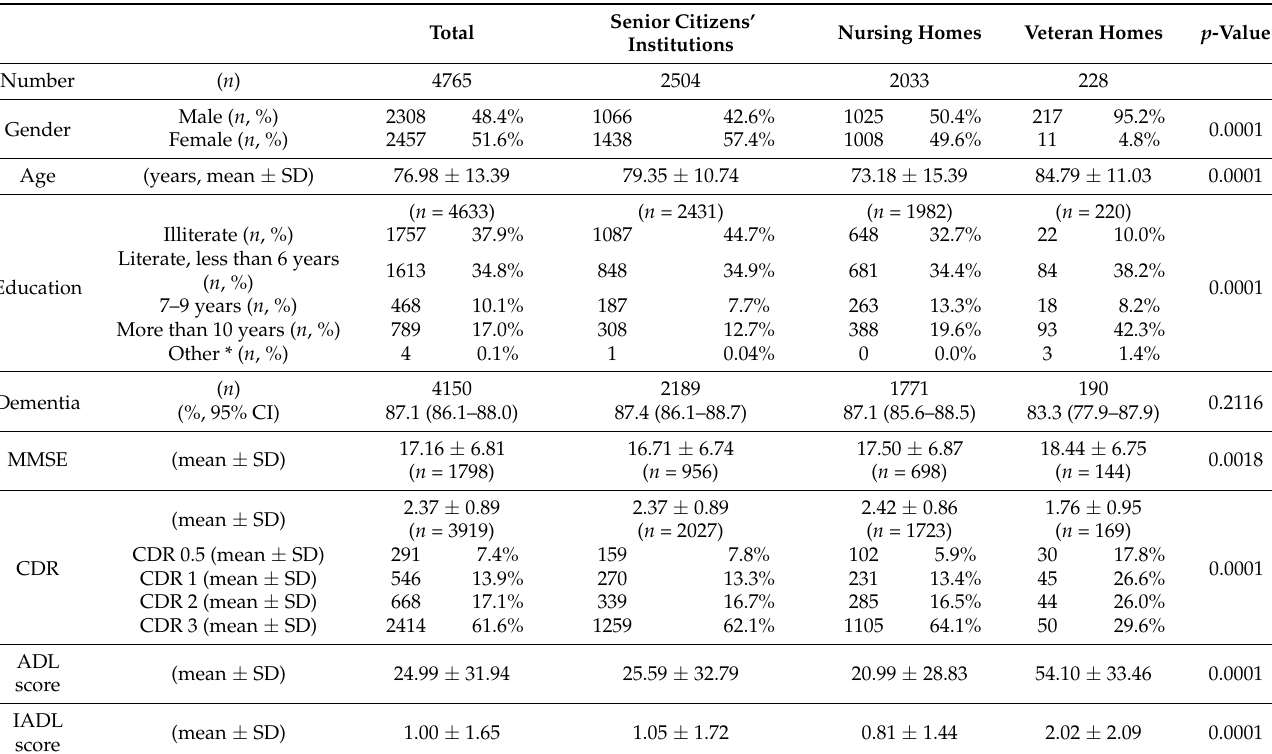
Table 1. Institutional basic